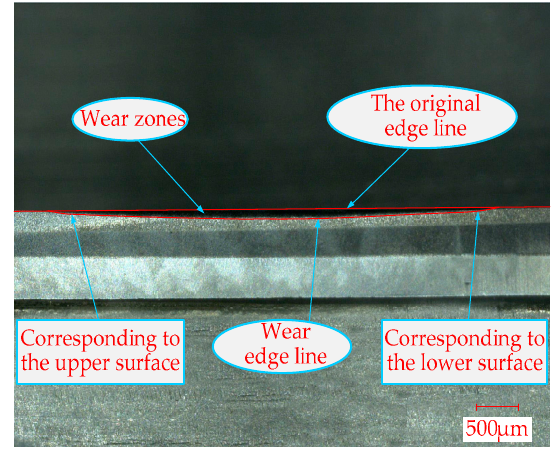
Figure 2. Flank wear topography of staggered PCD cutter after milling 84 m.